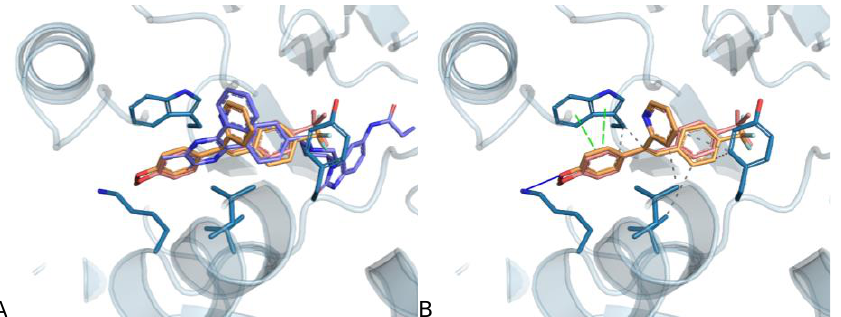
Figure 8. Predicted binding modes of compounds 10a (in salmon) and 12a (in orange) in the AKT binding site (PDB ID: 6S9W) ( A ) in comparison with the 6S9W co-crystallized ligand (in blue) and ( B ) with detailed information about the interactions established between our compounds and the AKT binding site obtained using PLIP [53] (plain line blue: HB; green dotted lines: π - stacking; grey dotted lines: hydrophobic.